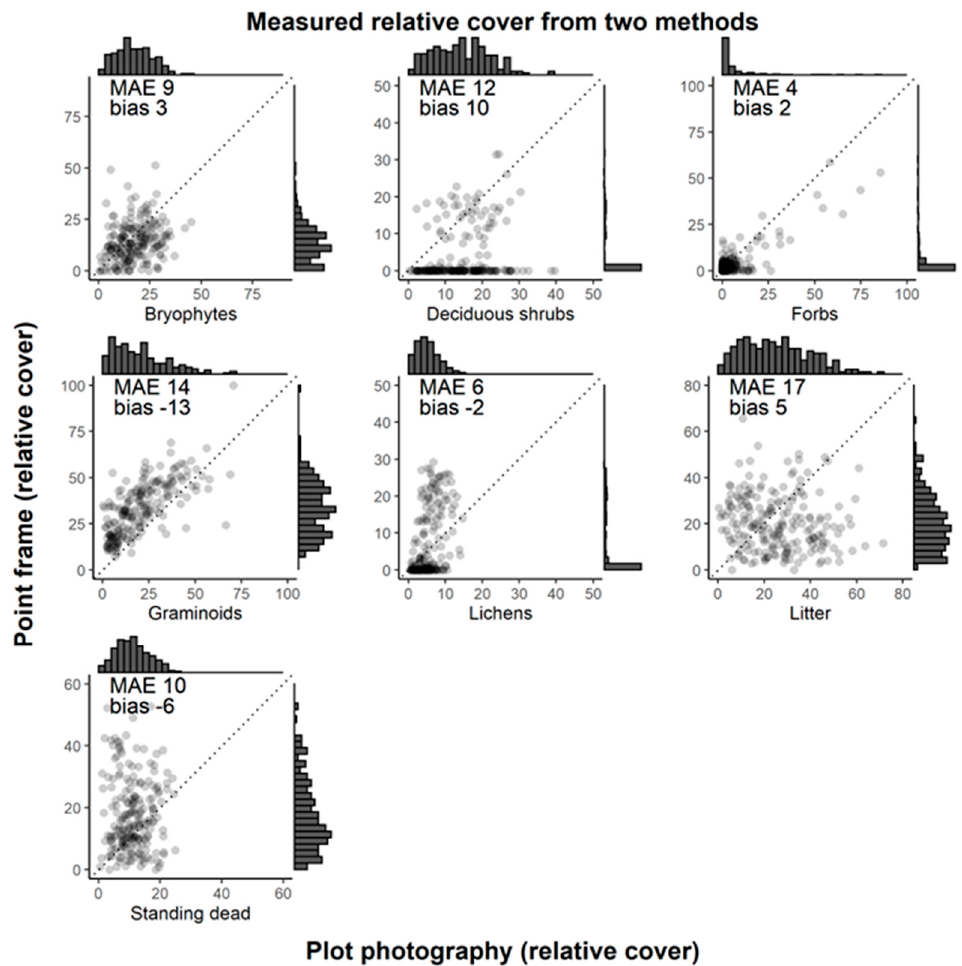
Figure 4. Cover estimates derived from the point frame and plot-level photography. Each point shows the cover of a vegetation class in each plot for each year sampled. The y-axis relates to the measured point frame cover, while the x-axis relates to the estimates from plot-level photography. Histograms on each axis show the distribution of values. Insets within each panel illustrate multinomial model performance using mean absolute error (MAE) and bias. The 1:1 reference line is included as a visual aid.